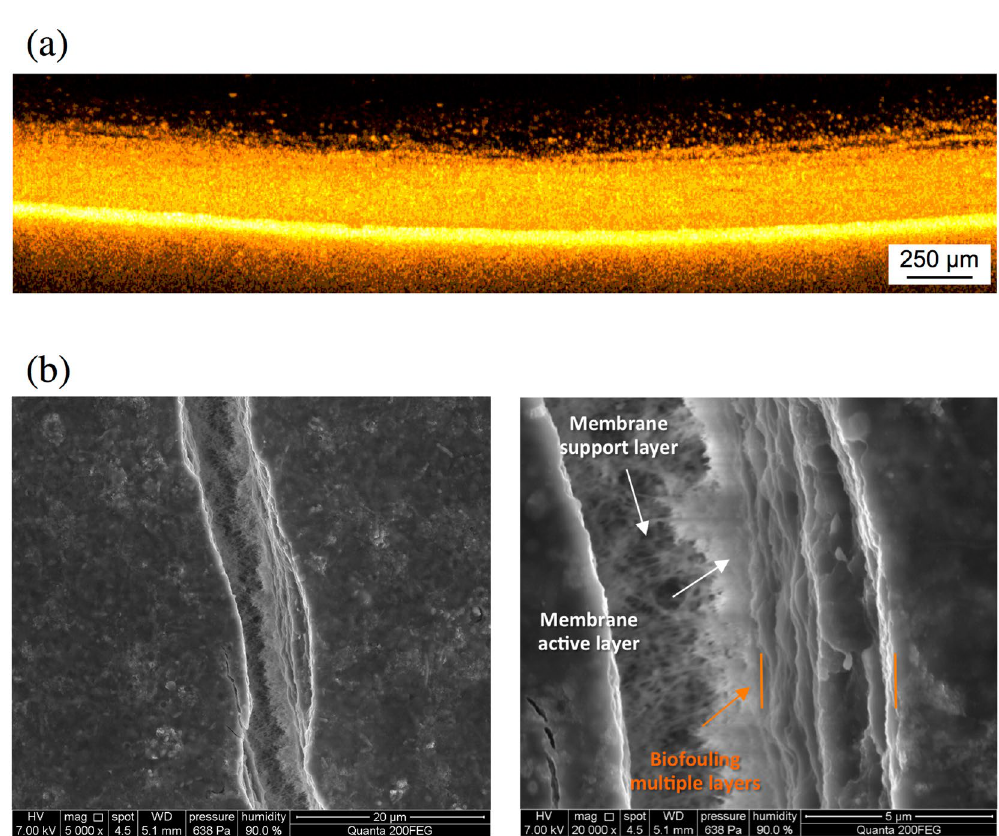
Figure 8. ( a ) OCT cross-sectional biofouling analysis after 42 d. It is possible to observe the presence of biofouling multilayers above the membrane. ( b ) ESEM tilted surface image of the fouling layer after 42 d. The fracture on the surface was produced by gradually decreasing the humidity in the